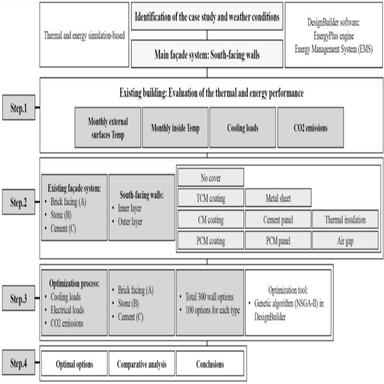
A brief overview of the research steps.